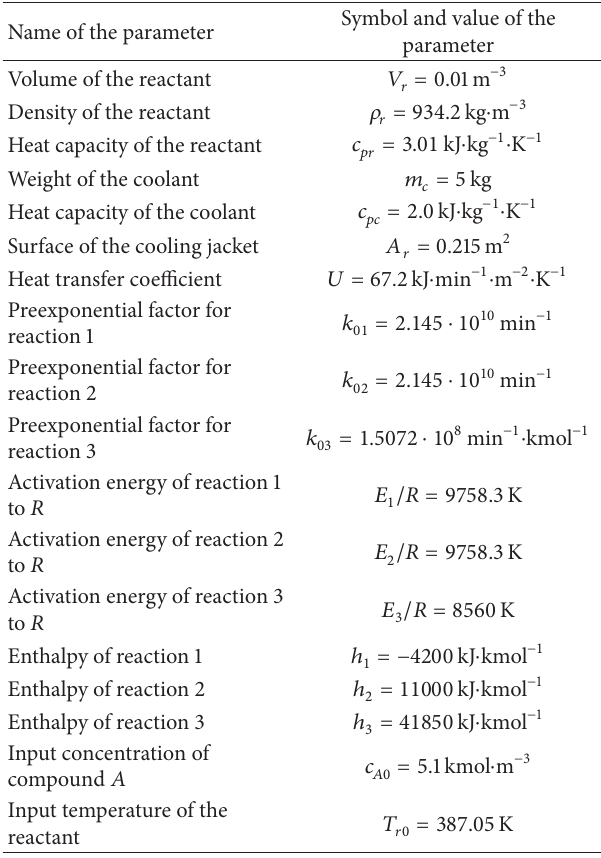
Table 1: Fixed parameters of the CSTR. Name of the